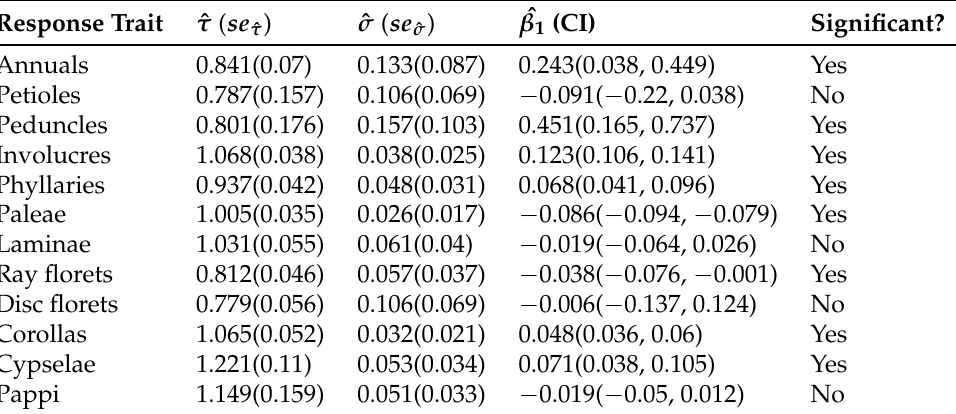
Table 3. The table provides estimates and corresponding standard errors for the hybrid effect (ˆ τ ), the rate of evolution (ˆ σ ), and the slope ( ˆ β ) for each of the 12 response traits of sunflowers under a network relationship. The slope estimate represents the effect of precipitation on the particular trait, with a positive value indicating a positive relationship and a negative value indicating a negative relationship. The 95% confidence interval (CI) for the slope estimate provides a range of plausible values for the true effect of precipitation on the